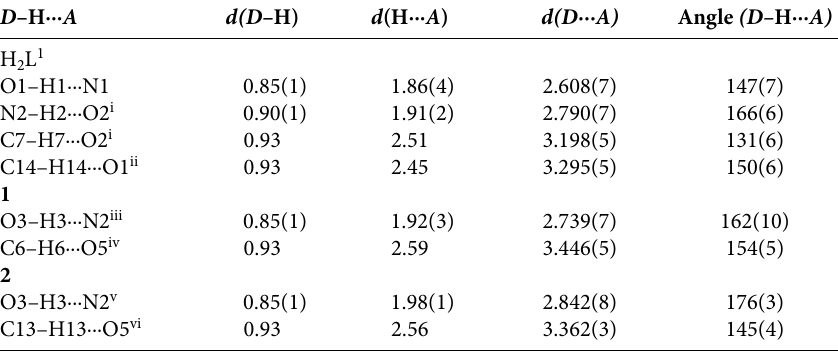
Table 3. Hydrogen bond distances (Å) and bond angles (°) for the compounds D –H∙∙∙